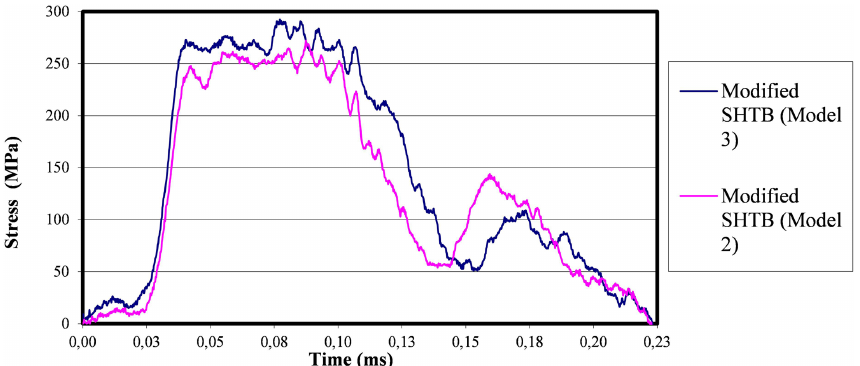
Figure 26. Incident stress-time curves pertinent to the actual experiment at 3.5bar when using 1mm thick and no damping rings.